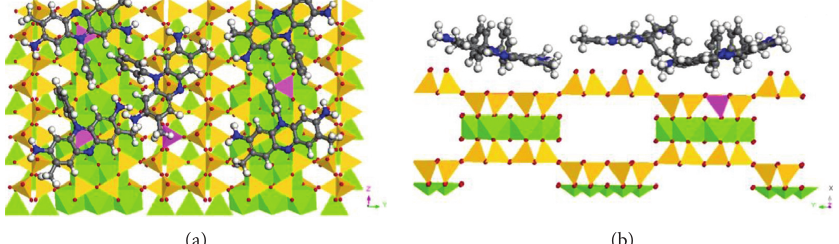
Figure 7: Molecular dynamic simulation showing SO uptake on the {100} surface (a) and projection along [001] (b) of PAL with 4 Si replaced with 4 Al in the